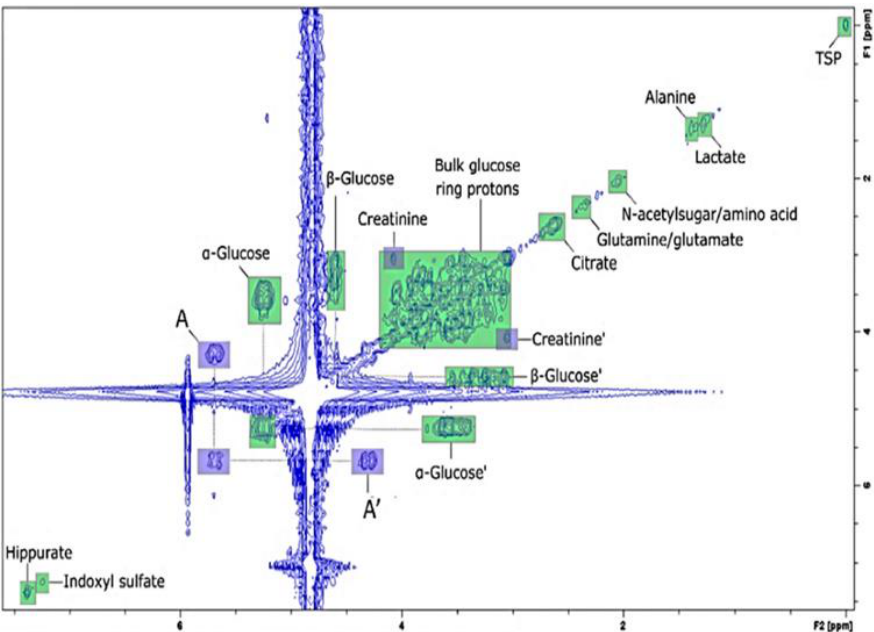
Figure 10. The 2D COSY NMR spectrum of urine from a patient with type 2 diabetes obtained using a 60 MHz benchtop NMR spectrometer. In the 1D spectrum, the glucose signal was hard to confirm because of its overlap with the water signal, whereas a cross-peak related to glucose was clearly observed in the 2D spectrum. Adapted with permission from [104], MDPI, 2019.